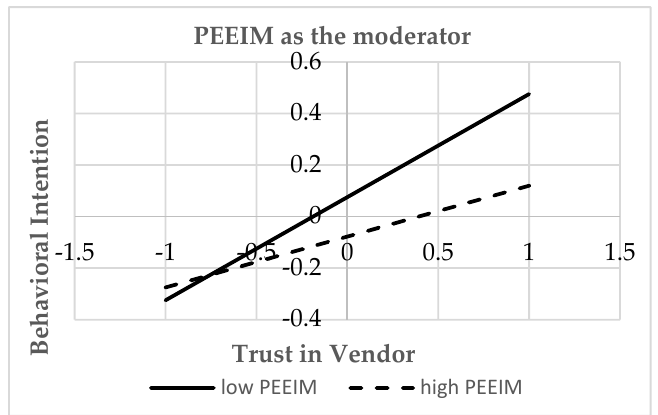
Figure 2. Moderation effect of PEEIM on the relationship between TV and BI in m-commerce adoption.